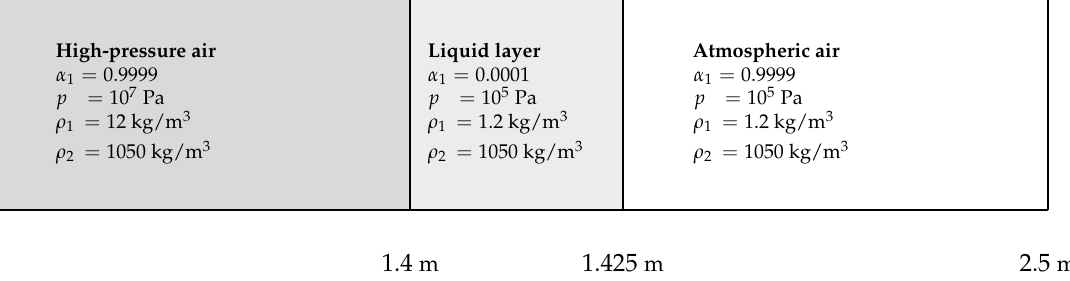
Figure 5. Simplified two-phase explosion test. A layer of liquid water is initially present in a 1D domain. The liquid volume fraction is α 2 = 0.9999 in this zone, and atmospheric conditions are considered p = 10 5 Pa, ρ 2 = 1050 kg/m − 3 . The liquid layer is surrounded by air on both sides. Material interfaces are then initially present. On the left side, the air is initially dense and at elevated pressure: p = 10 7 Pa, ρ 1 = 12 kg/m − 3 , and represents initial explosion conditions. On the right side, the air is at atmospheric conditions: p = 10 5 Pa, ρ 1 = 1.2 kg/m − 3 . The air volume fraction is initially α 1 = 0.9999 on both sides. The 1D domain is 2.5 m long. The liquid layer is placed at abscissa x = 1.4 m and is 0.025 m wide. The mesh consists on 2,500 regular elements, yielding a space step of ∆ x = 1 mm. Boundary conditions are